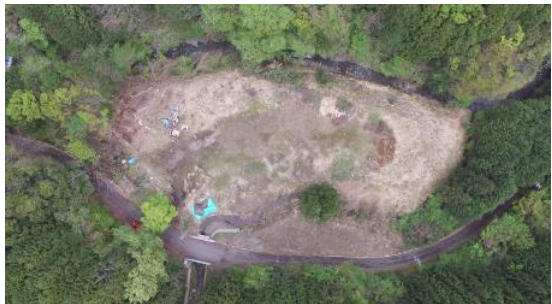
Figure 4. UAV test site taken by Inspire 1